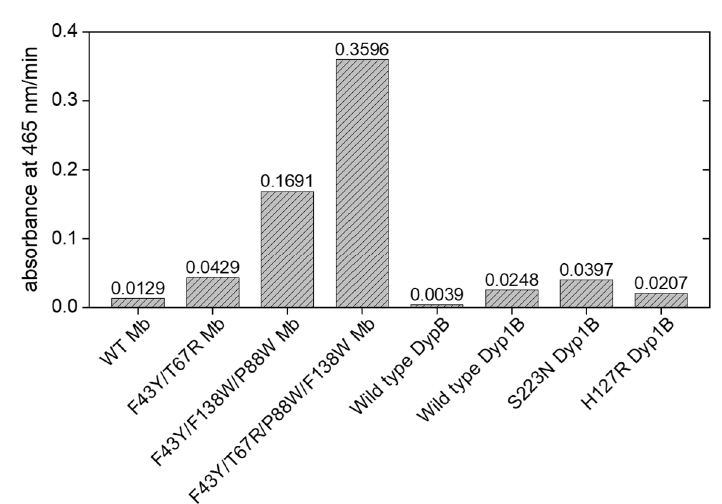
Figure 5. The enzymatic activities for Mb and its mutants in the oxidation of Kraft lignin, with the native Dyp and its mutants shown for comparison.